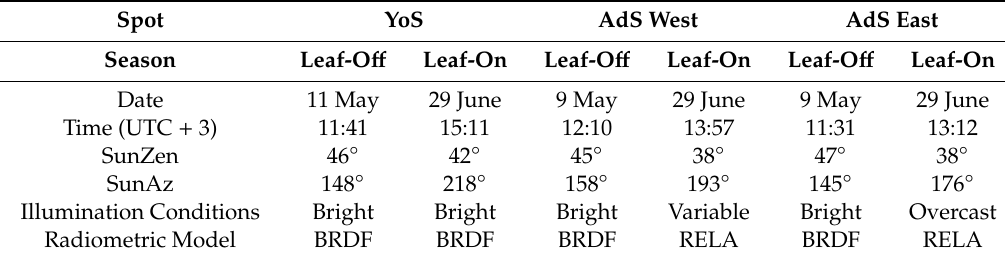
Table 3. Details of the UAV data capture in young seedling (YoS) and advanced seedling (AdS): date, time, sun zenith (SunZen) and azimuth (SunAz) angles, illumination conditions, and information about radiometric model used for FPI image processing (BRDF = bidirectional reflectance distribution function correction, RELA = relative image-wise